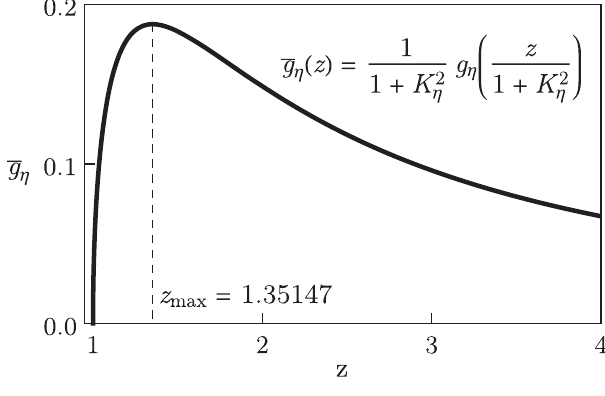
FIG. 19. Plot of ¯ g η ð z Þ given in Eq. (L8) for K η ¼